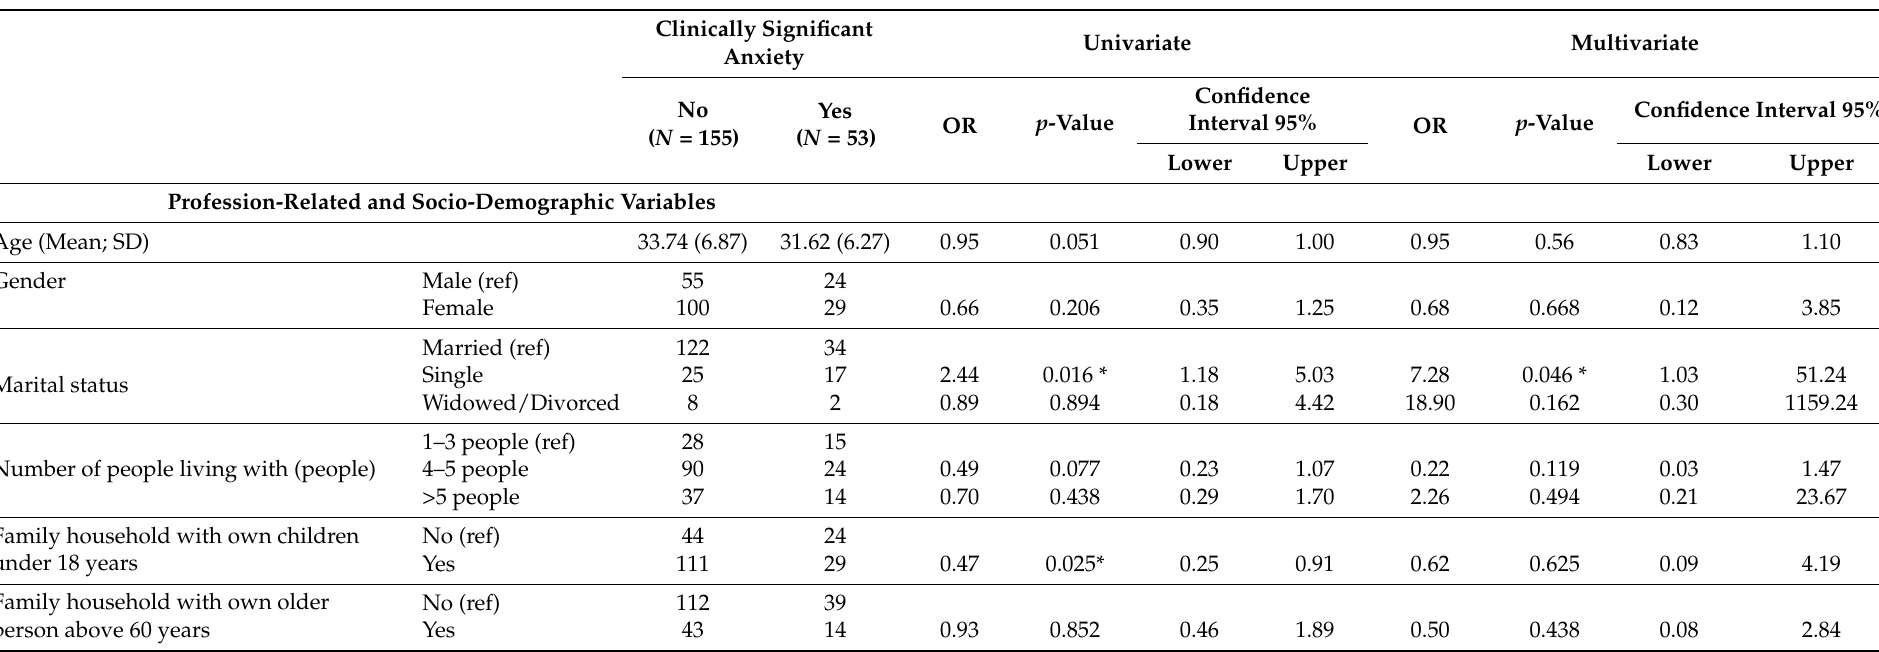
Table 6. Analysis of factors associated with the symptoms of anxiety: univariable and multivariable logistic